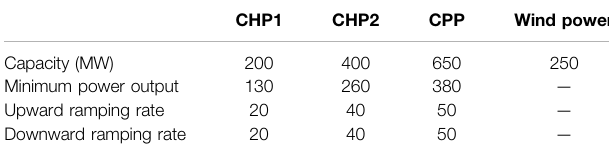
TABLE 1 | Installed capacities of different generators.